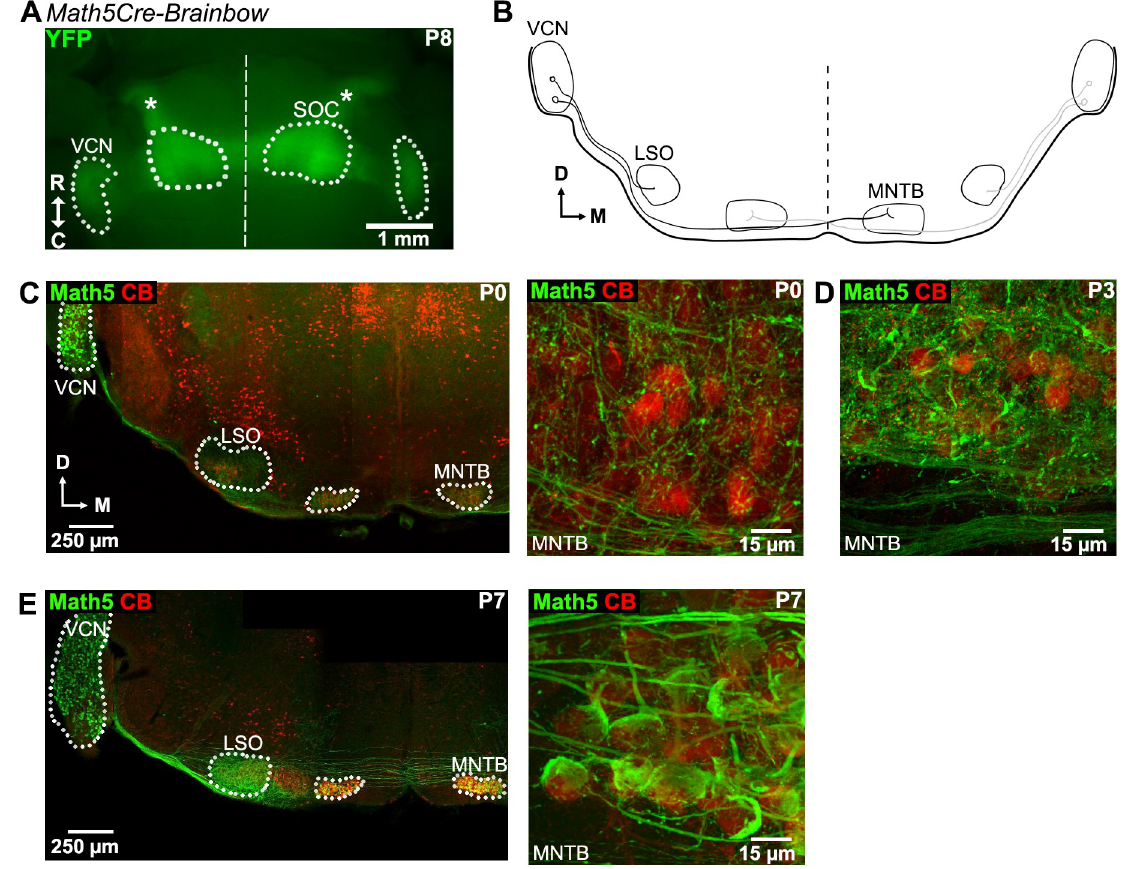
Fig 1. Visualization of bushy cell axons in Math5 Cre x Brainbow mice early postnatally. A , Ventral view of the brainstem of a P8 Math5 Cre x Brainbow mouse. The YFP fluorescence of the Brainbowreporter was excited by 470 nm excitationlight in a stereomicroscope equippedfor fluorescence. The extent of the VCN and of the superiorolivary complex(SOC) are outlined; the midlineis indicatedby the straight dashed line. Note the strongly YFP-positive ventral acoustic stria exiting the VCN, and the lateral lemniscus(star symbols). B , Schematicoverviewof a coronal section of the mouse auditorybrainstem. Bushy cells in the VCN projecting to the ipsilateralLSO and to the contralateralMNTB are indicated. C-E , Confocalimages of coronalsections of the auditory brainstemof Math5 Cre x Brainbow mice at three ages (C, P0; D, P3; E, P7). The sections were stained with an anti- GFP antibody (green channel; to detect the Cre-dependent YFP and CFP expressiondriven by the Brainbowreporter mouse; labelled"Math5"), and with an anti-Calbindinantibodyas a marker for MNTB neurons(red channel). Note the presenceof Math5 —positiveaxons with few collaterals and no large nerve terminals at P0 (C, right ); with more numerouscollateralsat P3 (D), and with large calycealnerve terminals at P7 (E, right